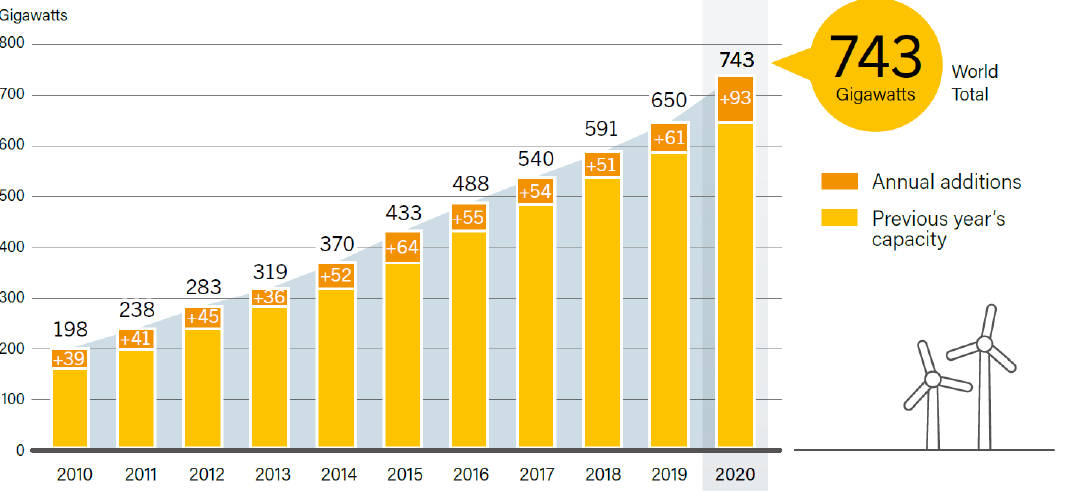
Figure 1. Wind power global capacity and annual additions, 2010–2020 [1].